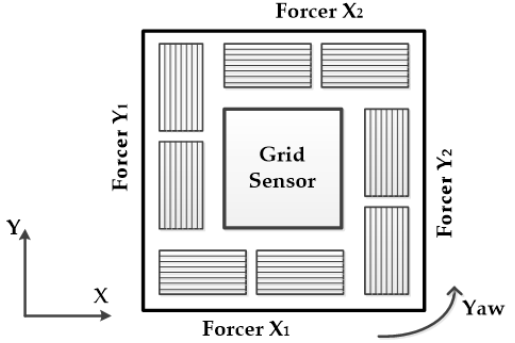
Figure 1. Top view of a planar motor.